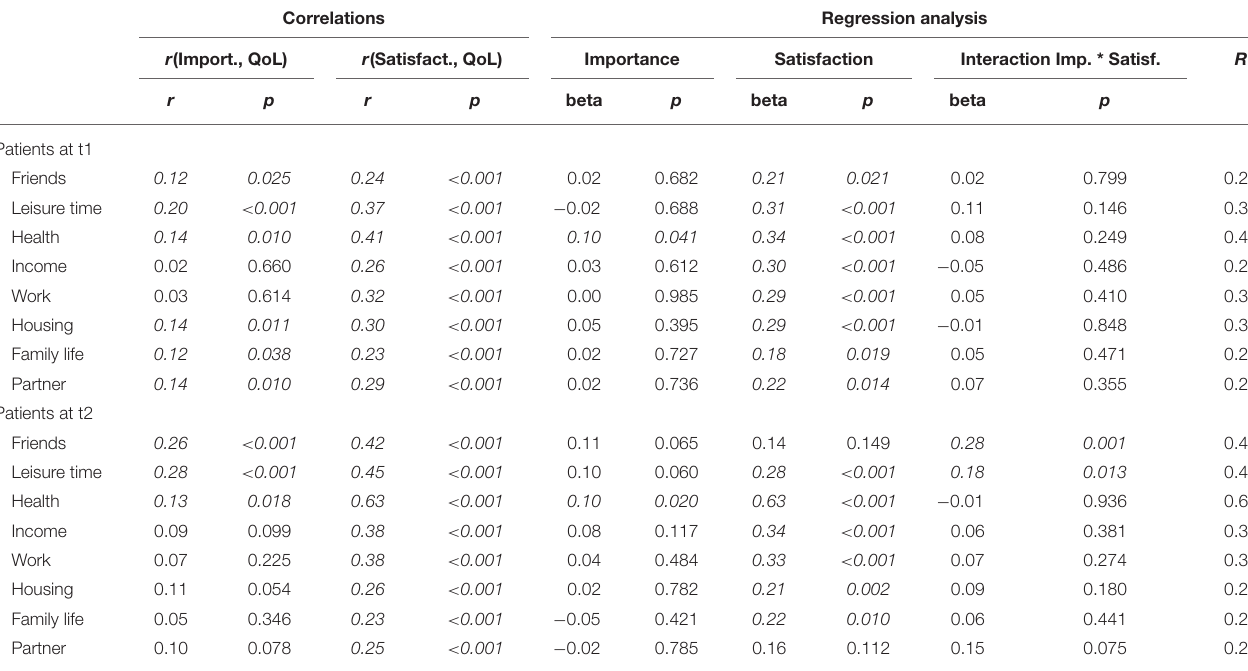
TABLE 4 | Correlation and regression analyses, predicting global QoL from importance, satisfaction, and the interaction of importance and satisfaction, for patients at t1 and t2. Correlations Regression analysis Importance Satisfaction Interaction Imp. *